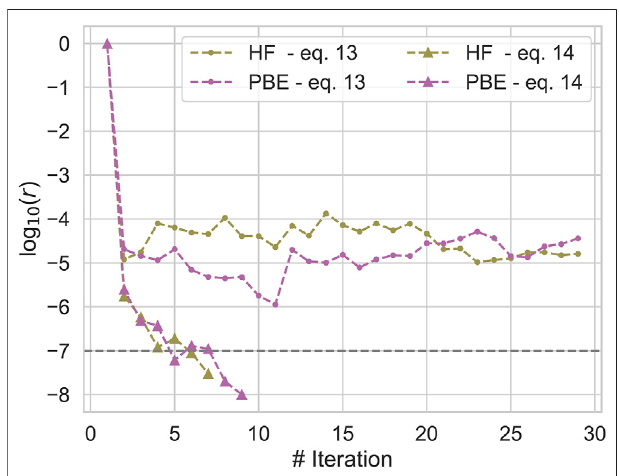
FIGURE 1 | Convergence of the qs GW SCF for Methane for different initial guesses and constructions of the correlation potential. log 10 r , r de fi ned in Eq. 26 , is plotted against the number of